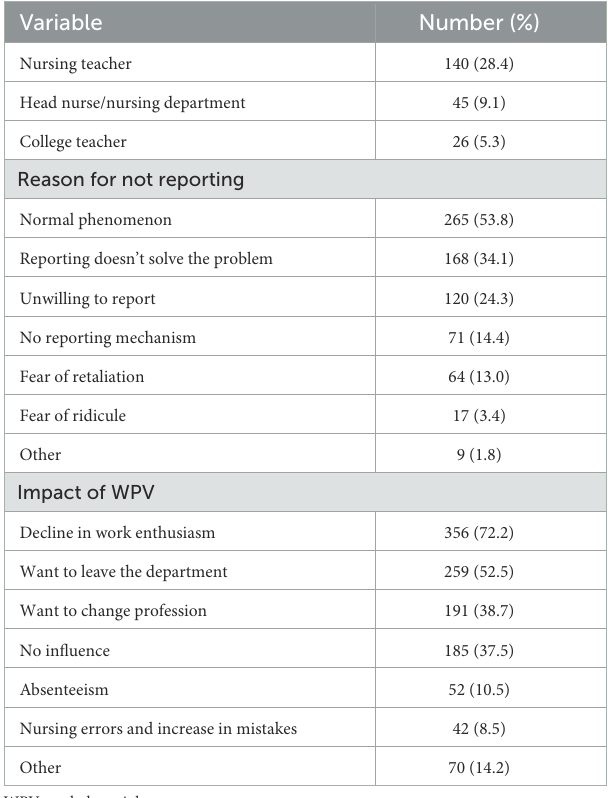
TABLE 3 Characteristics of psychological WPV ( n =